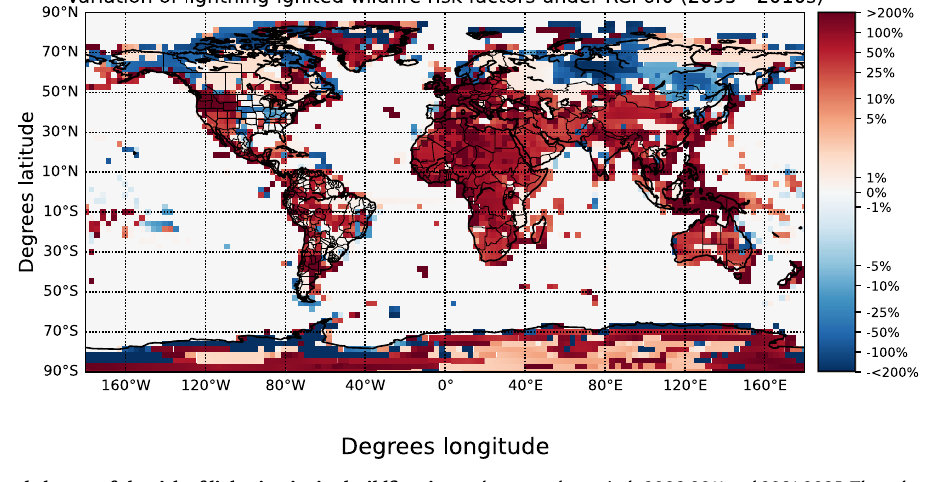
betweentheperiods2009-2011and2091-2095.Thecolorbarhasbeendeliberately saturated at the upper and the lower ends due to the high variability of the plotted